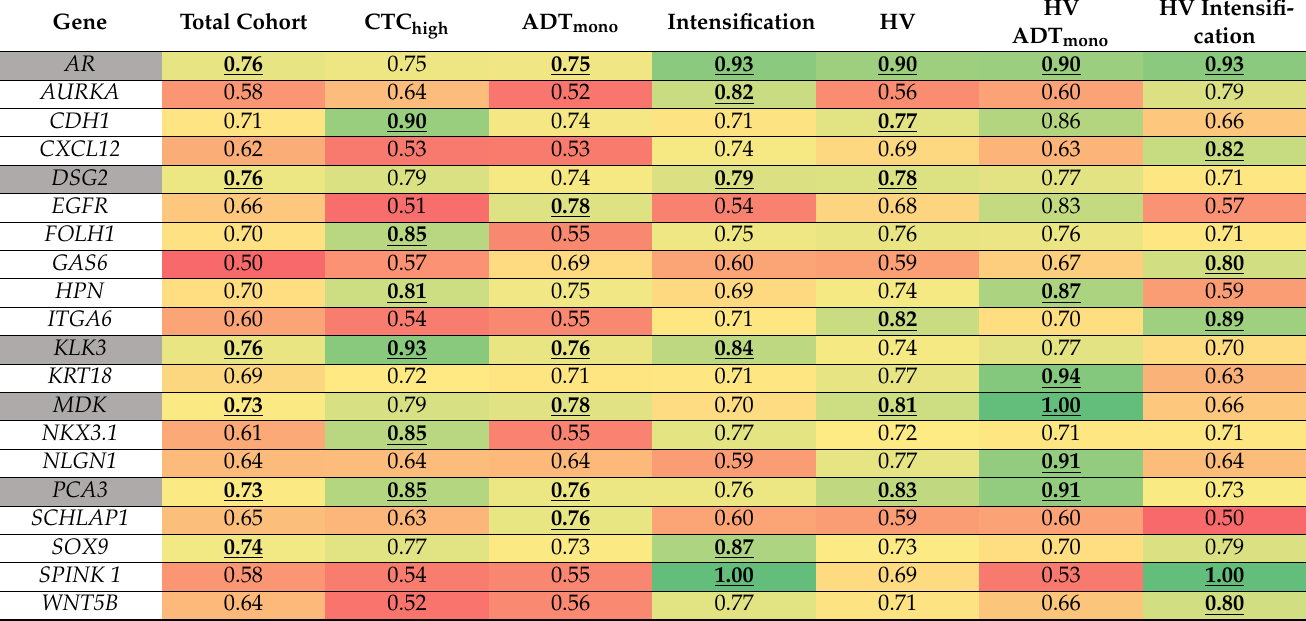
Table 4. Area under the curve (AUC) values are given for differentially expressed genes between responders and nonresponders across all patients (Total Cohort), as well as within key subgroups. These subgroups included patients with a high CTC probability (CTC high ), patients who received ADT monotherapy (ADT mono ), patients who received treatment intensification (Intensificaiton), all CHAARTED high-volume patients (HV), CHAARTED HV patients who received ADT monotherapy (HV ADT mono ), and CHAARTED HV patients who received treatment intensification (HV Intensifi- cation). The top 6 scoring genes for each cohort are highlighted in bold-underline font, and the top 5 scoring genes in common between all cohorts are highlighted in grey in the gene